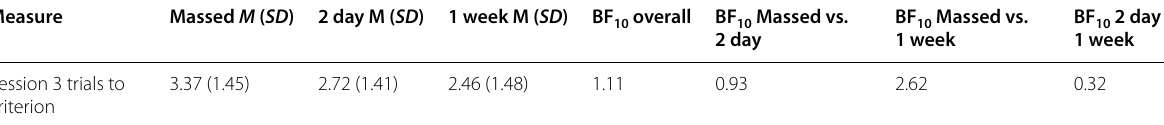
Table 9 Session 3 trials to criterion, for massed, 2-day, and 1-week ISIs